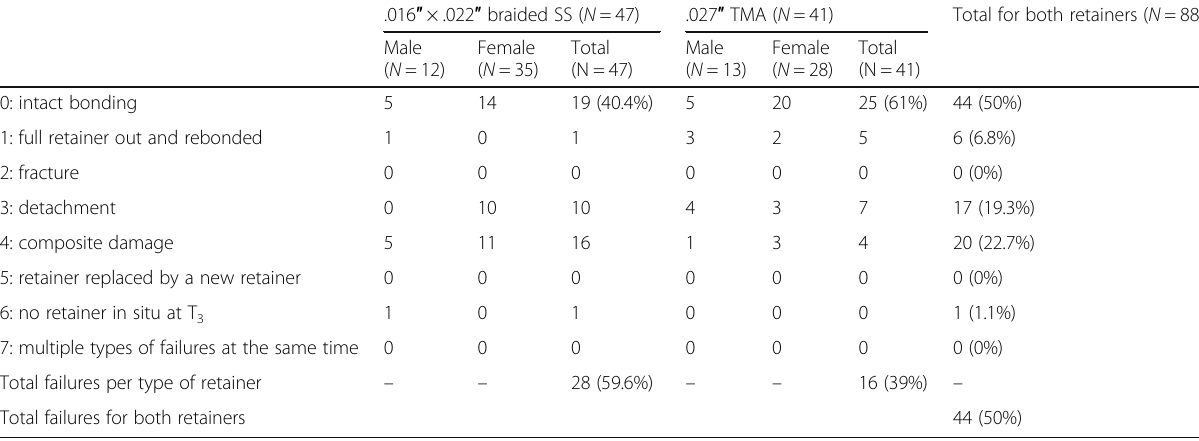
Table 2 Type of first failure for the mandible